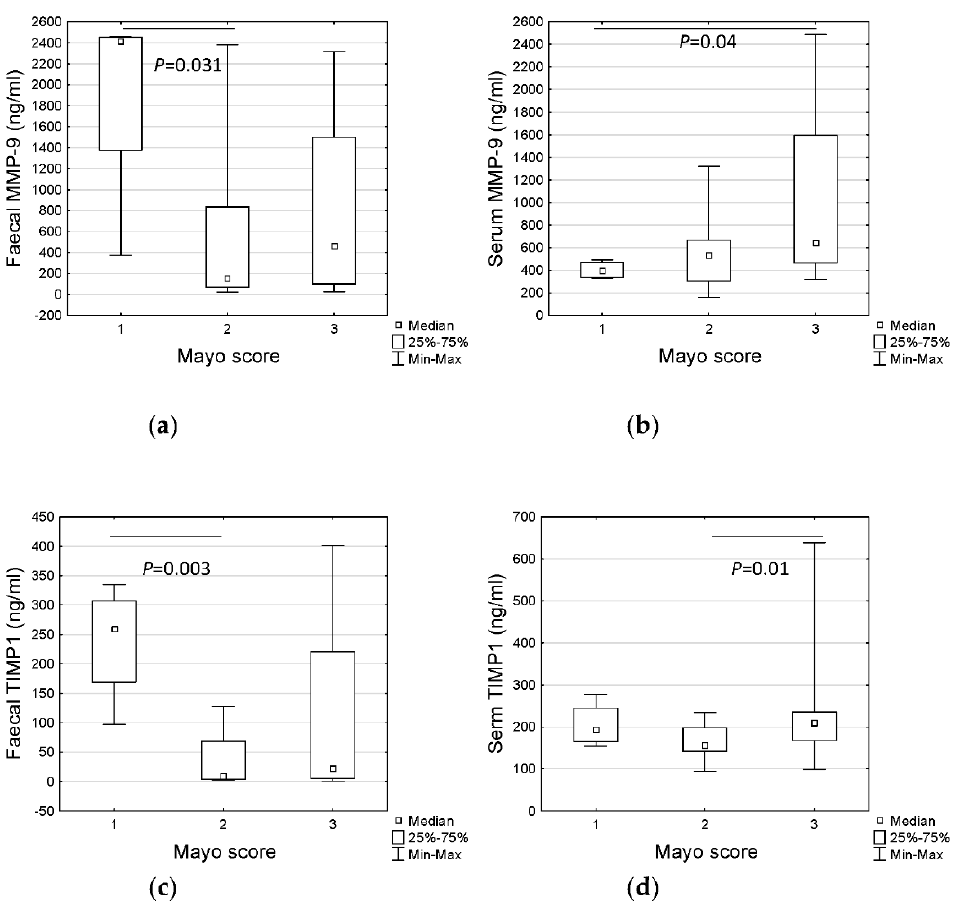
Figure 2. Differences in MMP-9 (faecal—( a ), serum—( b )) and TIMP-1 (faecal—( c ), serum—( d )) concentration based on the severity of the lesions in the colonic mucosa (Mayo Endoscopic Score). MMP-9—matrix metalloproteinase-9, TIMP-1—tissue inhibitor of metalloproteinase-1, Mayo—Mayo Endoscopic score: 1—erythema, decreased vascular pattern, mild friability, 2—marked erythema, erosions, no vascular pattern, friability, 3—ulceration, spontaneous bleeding. Statistical analysis performed using Kruskall–Wallis test supplemented with the post-hoc test.